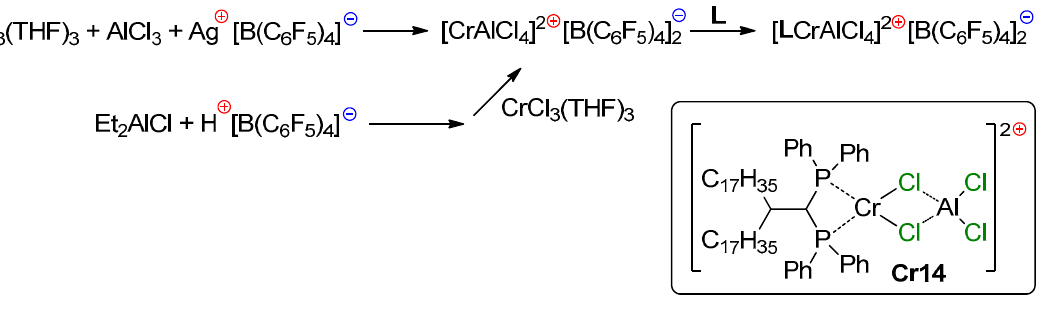
Figure 31. Molecular structure of complex Cr12 [246].